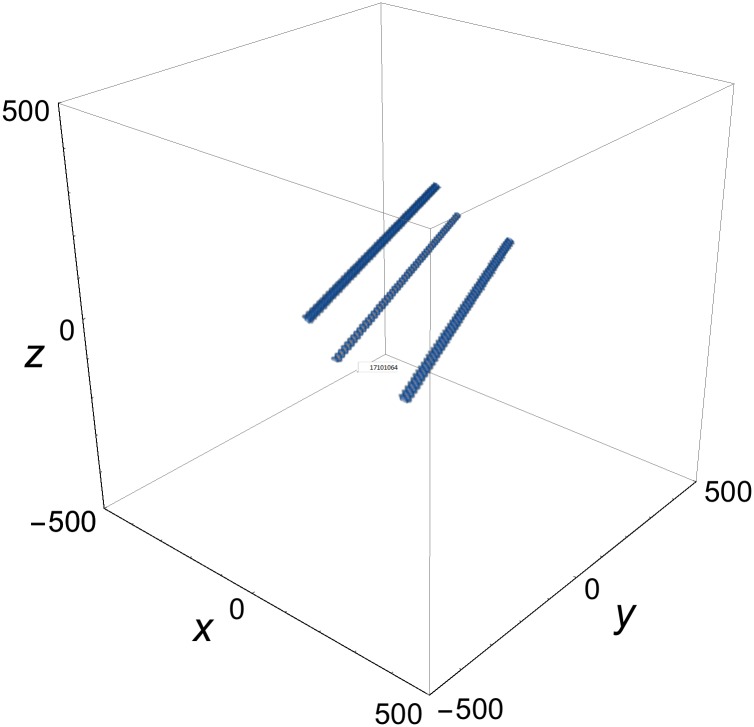
Three parallel-rod solution of Eq (3) at t = 0.p(1) = {1, cosφ(1), sinφ(1), 1}, p(2) = {2, cosφ(2), sinφ(2), 2}; p(3) = {p0, cosφ(3), sinφ(3), p0} = αp(1) + βp(2); α = −1.65449; β = 2.60004; φ(1) = π/5, φ(2) = π/4, φ(3) = π/3δ(1) = 0, δ(2) = 50, δ(3) = −50.